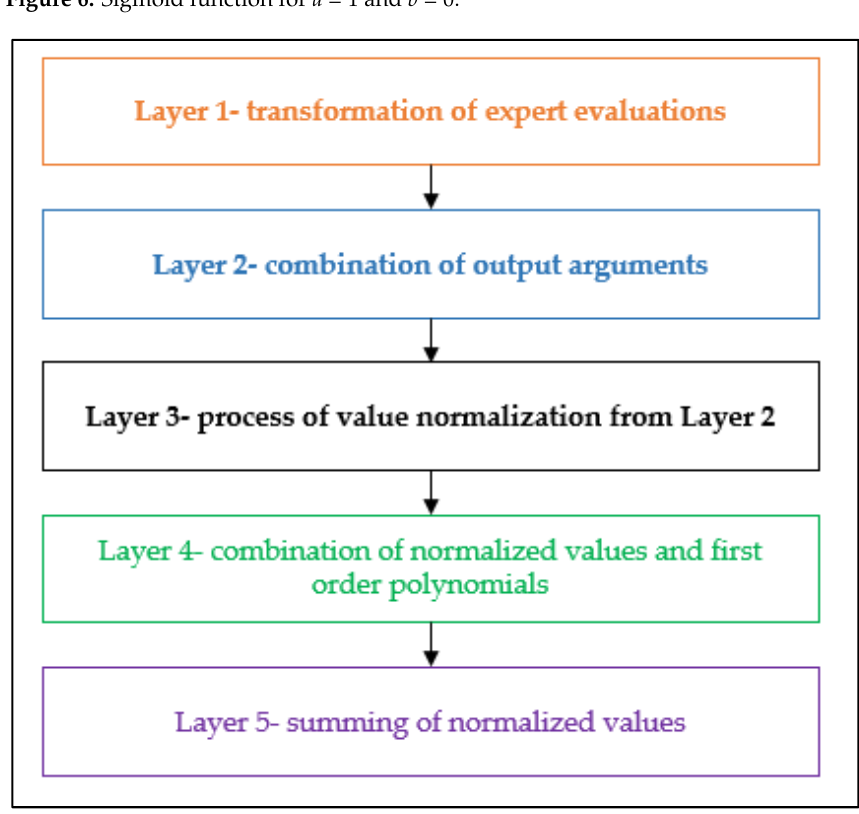
Figure 7. ANFIS layers [18].